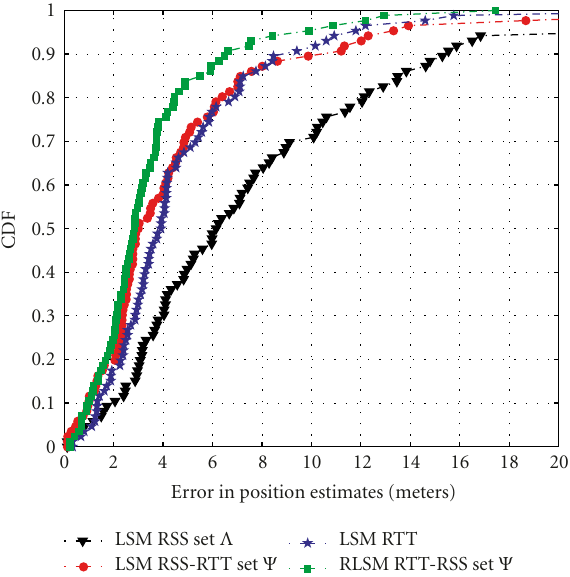
Figure 8: CDFs of errors in position estimate depending on the multilateration method and set of constraints used in a real environment, the second floor of the ETSIT